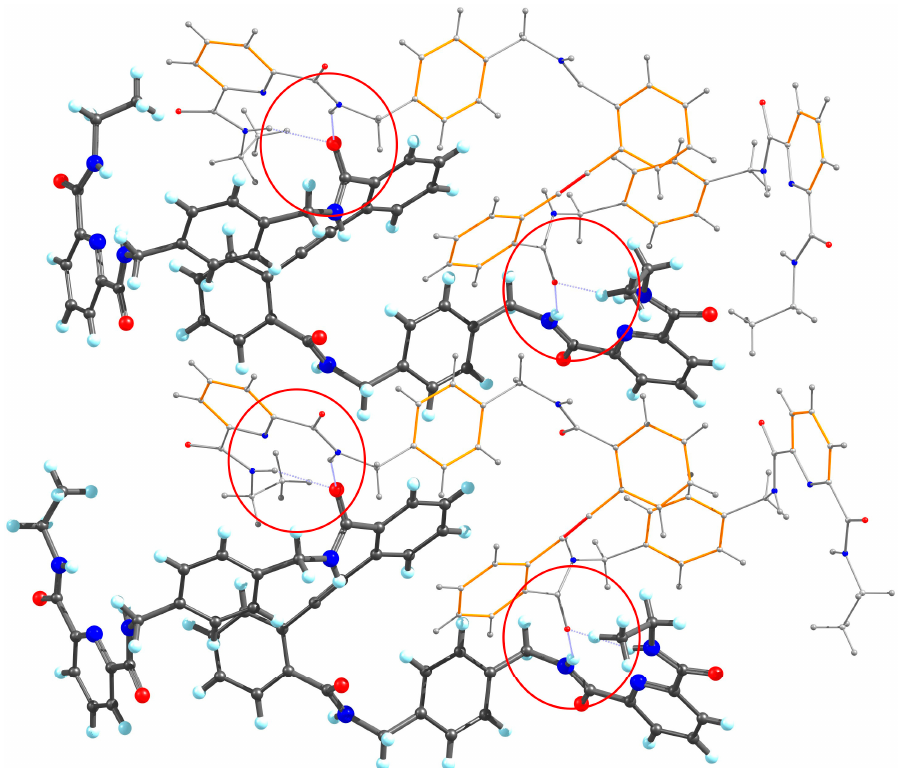
Figure 3. Molecular structure of receptor 2 according to the single crystal X-ray analysis; the hydrogen bonding interactions between molecules in the crystal lattice marked with red circles. Average distance and torsion angle of hydrogen bonds are 2.92 Å and 156°, respectively.